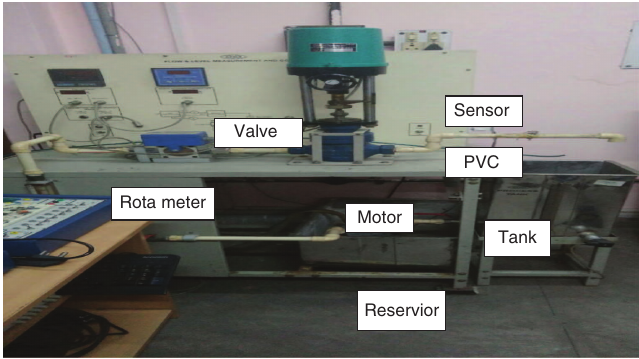
Figure 2: Experimental Setup for Liquid Flow Rate Measurement